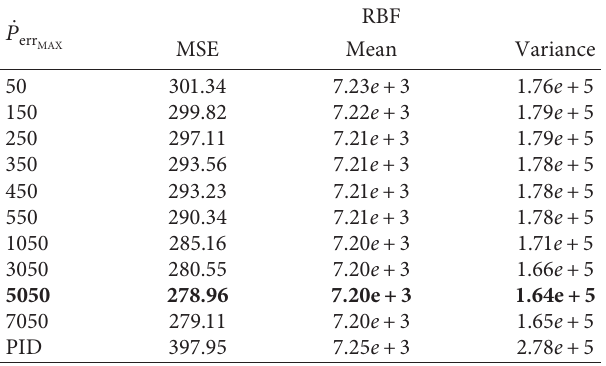
Table 8: Variation of MSE, output power mean, and variance with K